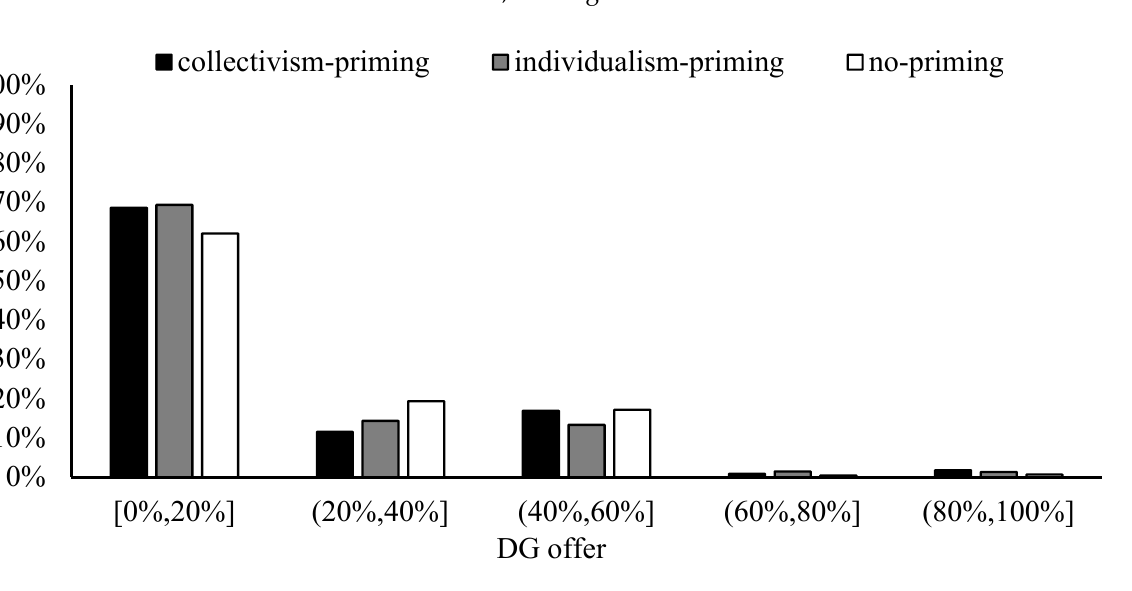
Table 3. Regression analysis of three treatments of offer.